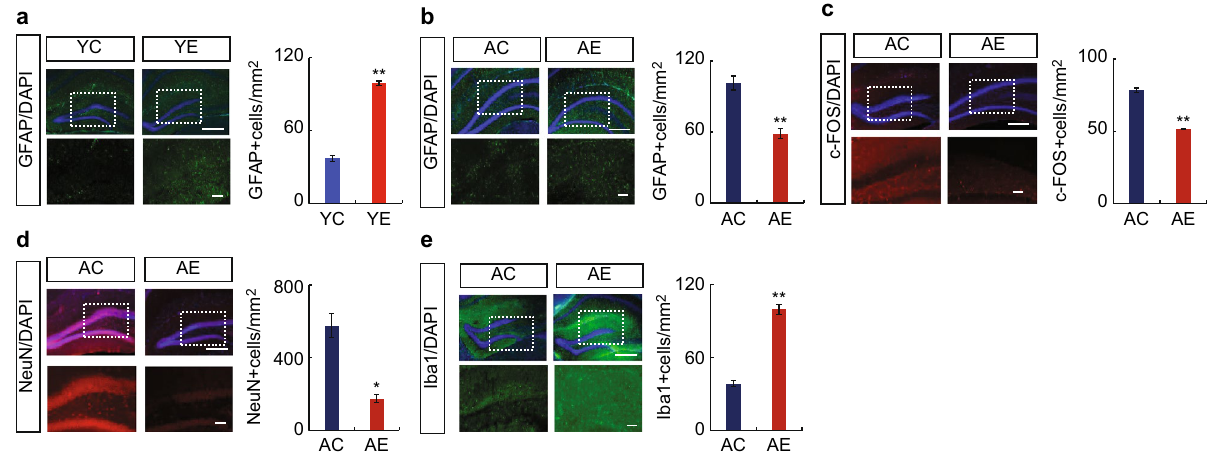
Figure 4. Effects of maxillary molar loss on protein expression in the hippocampus of mice (Immunostaining). Astrogliosis is induced in the hippocampus of mice with missing molars. The hippocampus and protein expression are shown. The square made by the dotted line is the CA1 region of the hippocampus, shown enlarged below. ( a ) Typical GFAP-positive cell area (mm 2 ) and graphs showing the hippocampus of control and extraction groups of young mice (YC3 vs. YE3). ( b–e ) Typical staining images and graphs showing the hippocampus of control and extraction groups of aged mice (AC3 vs. AE3); ( b ) GFAP, ( c ) c-FOS, ( d ) NeuN, ( e ) Iba-1. The number of c-FOS- and NeuN-positive cells were increased, and c-FOS and NeuN positive cells were decreased upon tooth extraction. Scale bar: 100